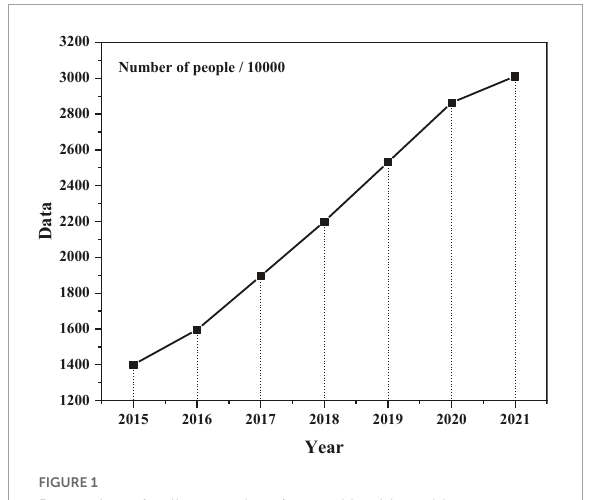
FIGURE1 Proportion of college students’ mental health